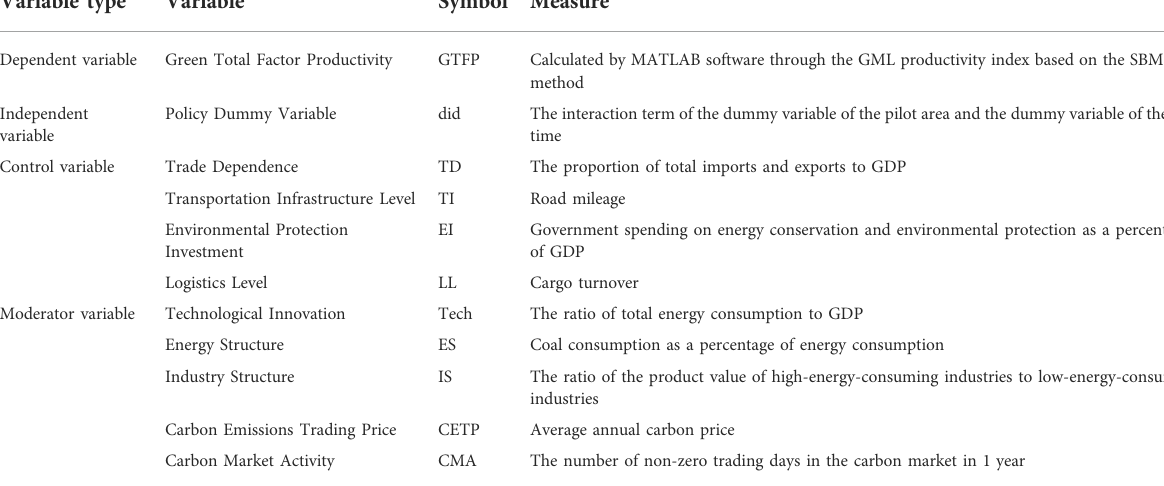
TABLE 1 Variable de fi nition and measurement.